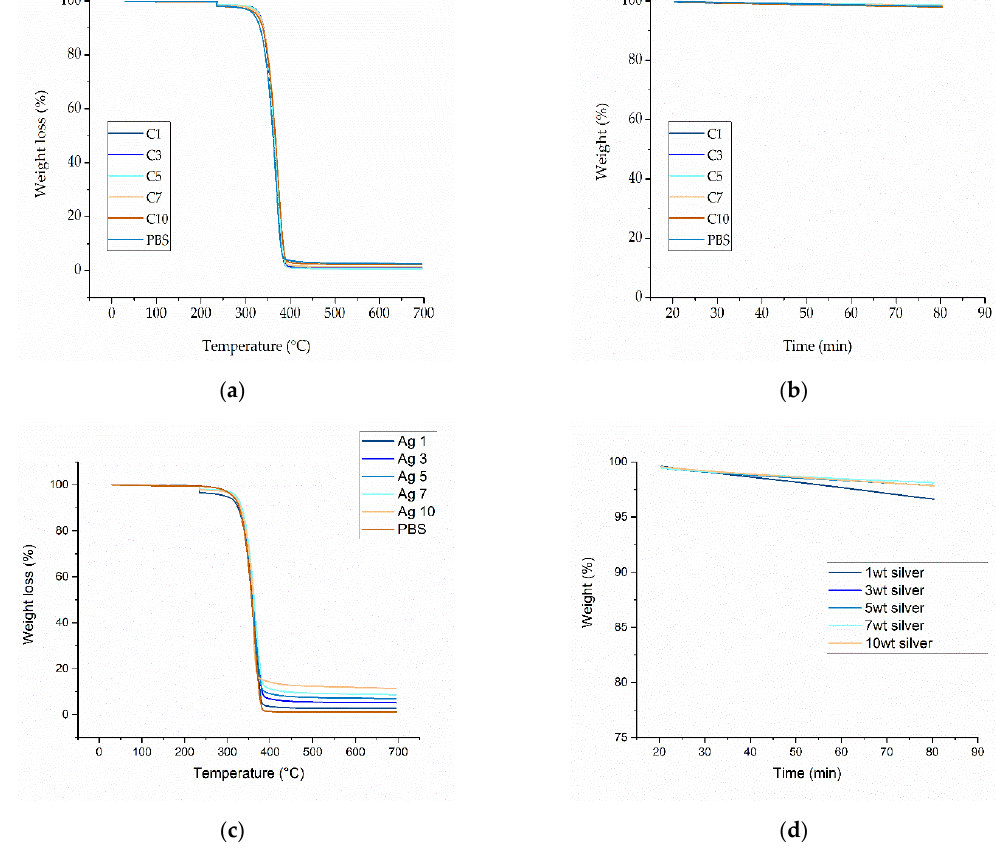
Figure 7. Thermogravimetric analysis (TGA) of the PBS compounds. ( a ) Temperature-dependent degradation profile of PBS compounds with increasing weight percentages of curcumin. ( b ) Isother- mal study of PBS compounds with increasing weight percentages of curcumin for 60 min at 235 ◦ C. ( c ) Temperature-dependent degradation profile of PBS compounds with increasing weight percent- ages of silver. ( d ) Isothermal study of PBS compounds with increasing weight percentages of silver for 60 min at 235 ◦